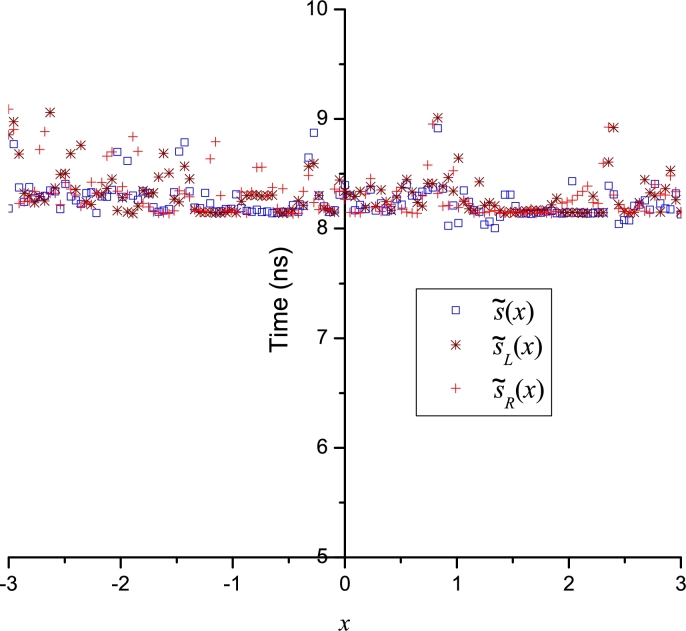
CPU time for LP approximation of the nonlinear problem with a discontinuity.